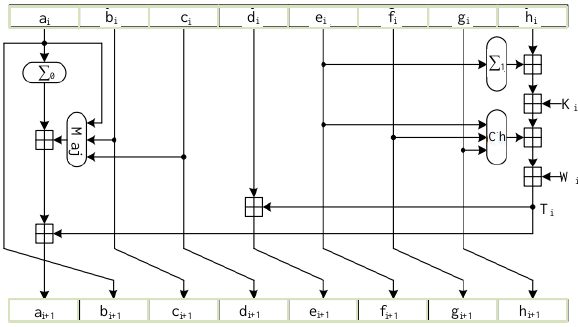
Figure 6. The implementation steps of